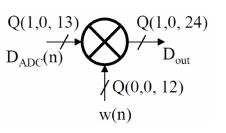
Figure 11. Number format for the window function multiplication.